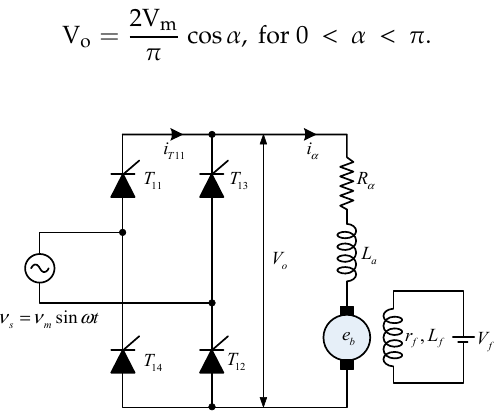
Figure 6. Single-phase fully-controlled converter drive.